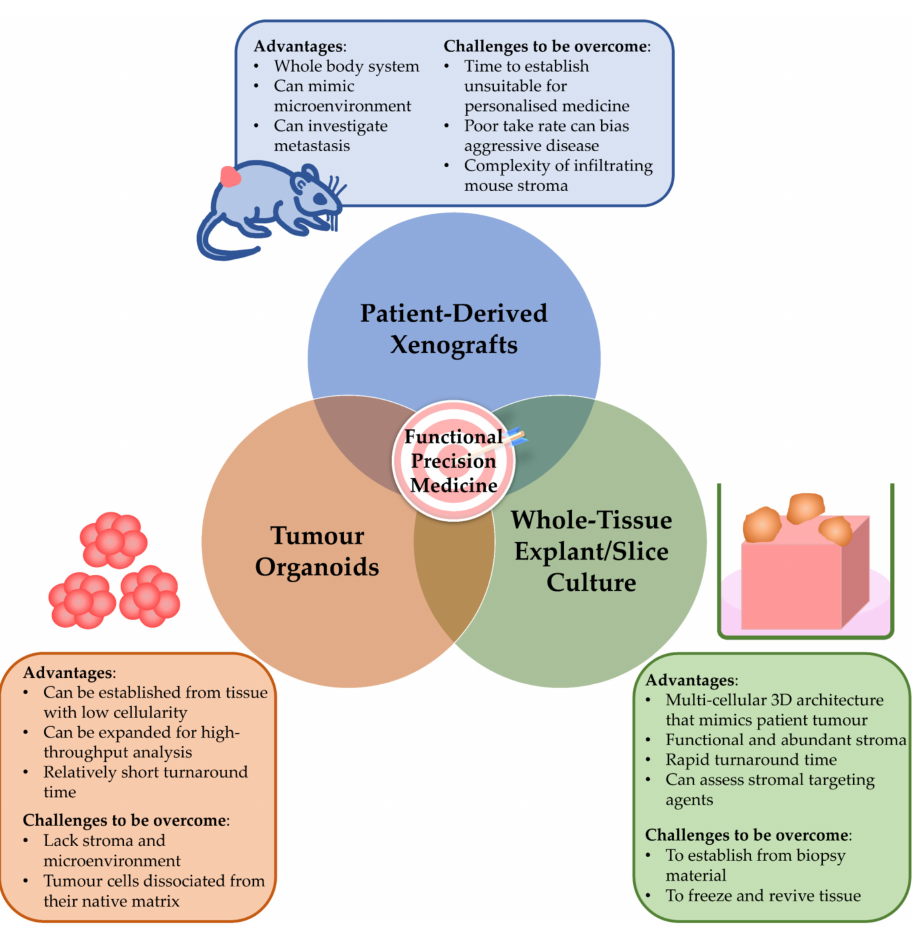
Figure 2. Pre-clinical models to inform functional precision medicine in pancreatic ductal adeno- carcinoma. Patient-derived pre-clinical models are needed to inform functional precision medicine. Importantly, each model has its strengths and limitations, and these need to be addressed when choosing models to guide precision